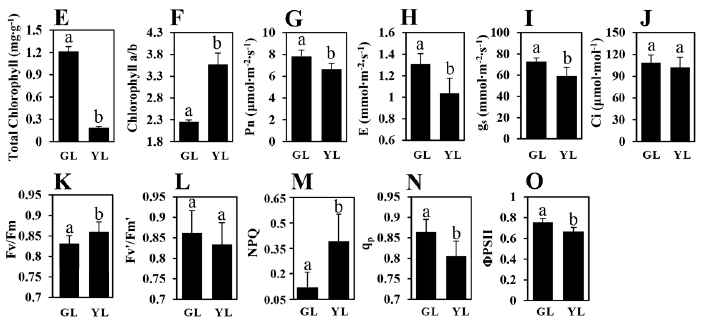
Figure 1. Photosynthetic parameters and chloroplast ultrastructure of ginkgo yellow-colour leaves (YL) and green-colour leaves (GL). ( A , B ) Phenotypes of the GL (left) and YL mutant (right); ( C , D ) Chloroplast ultrastructure in GL ( C ) and YL ( D ). S, starch grain; T, thylakoid; O, osmiophilic granule; ( E , F ) Total chlorophyll content and chlorophyll a/b; ( G – J ) Gas exchange parameters in P n ( G ), E ( H ), g s ( I ), C i ( J ); ( K – O ) Changes in chlorophyll fluorescence parameters, including maximum quantum efficiency of photosystem II (PSII) (Fv/Fm) ( K ), efficiency of excitation energy capture by open PSII centres (Fv ′ /Fm ′ ) ( L ), nonphotochemical quenching (NPQ) ( M ), photochemical quenching (q p ) ( N ), effective quantum yield of PSII electron transport ( Φ PSII) ( O ). The values are presented as means ± SD ( n = 15). Different letters indicate significant differences at p < 0.05.